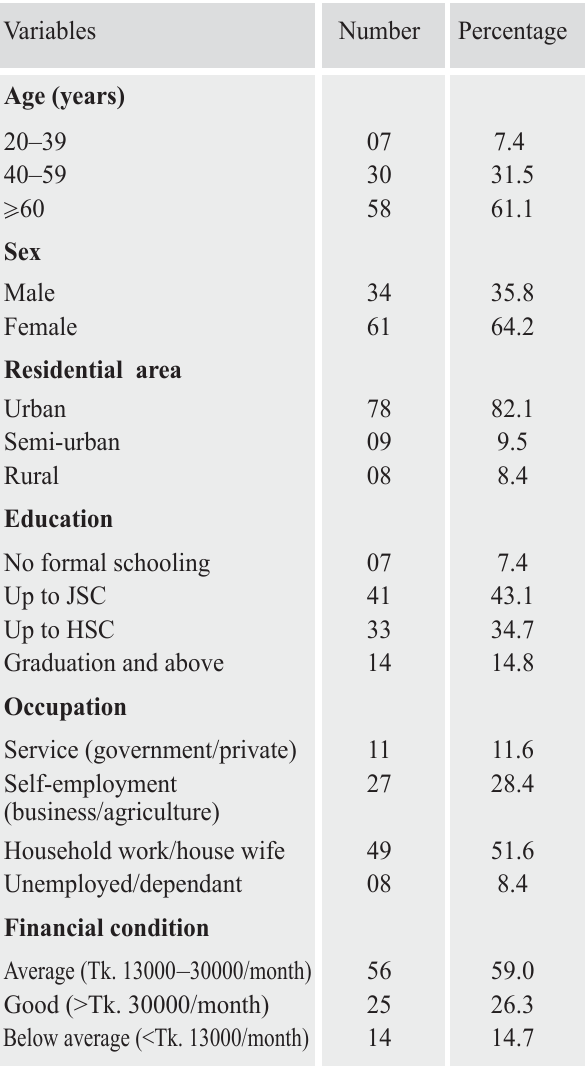
Table I: Socio-demographic profile of the study